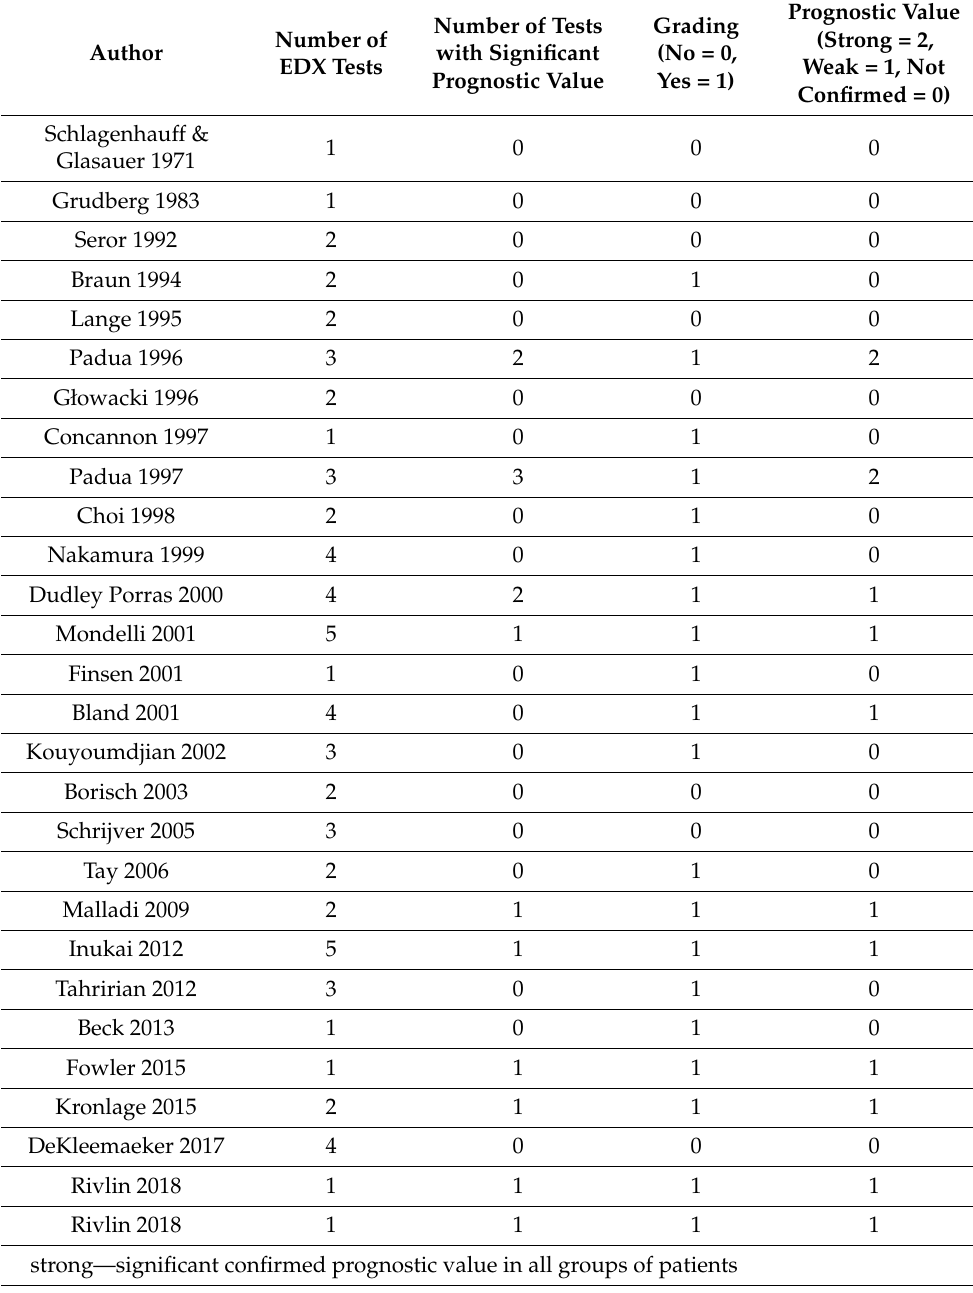
Table 2. Pre- and postoperative clinical and electrophysiological evaluation of patients with